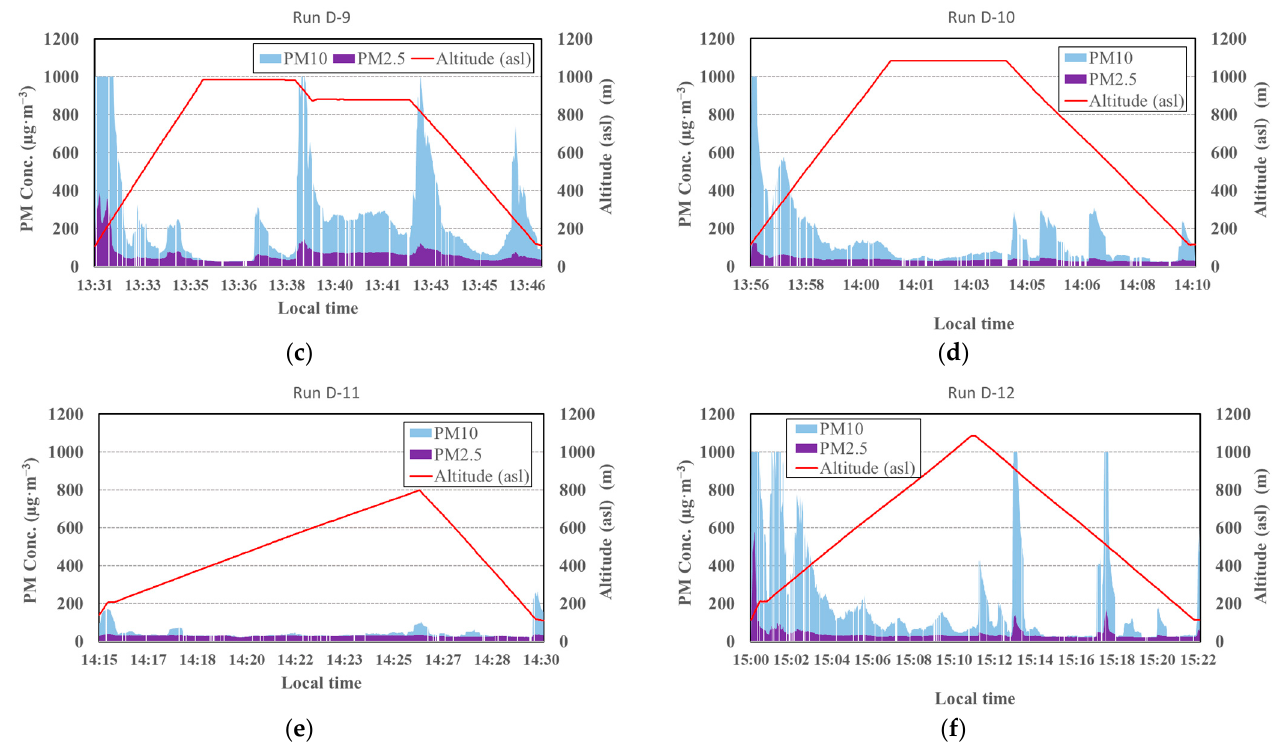
Figure 10. Time series variation of drone-measured PM 10 and PM 2.5 concentrations on 27 February 2020 (Runs D-7 to D-12) at the Arimura site. Red lines show the altitude (asl) of flight. Flight pattern of ( a – d ) was Protocol A (i.e., “hovering”), and pattern of ( e – f ) was Protocol B (i.e., “moving”).